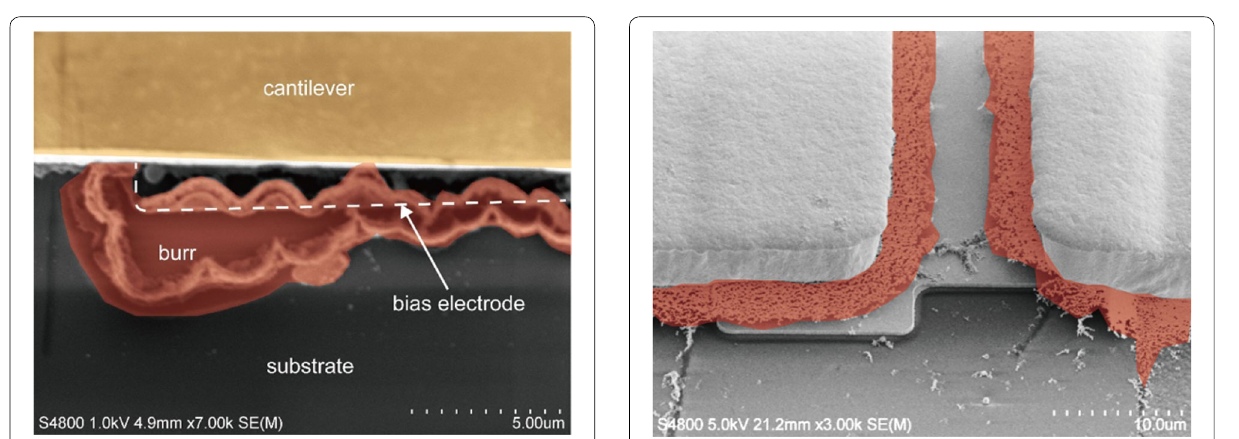
Fig. 7 SEM image of the remained Au seed layer after the Ar IBE process. For clarity, the remaining Au seed layer is colored